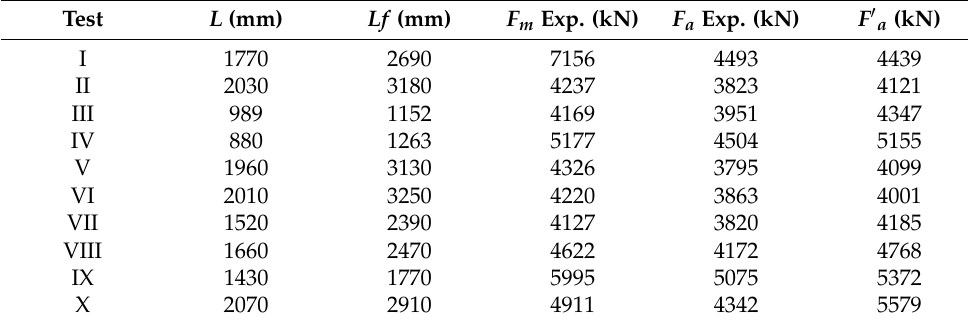
Table 3. Test results and F (cid:48) a .